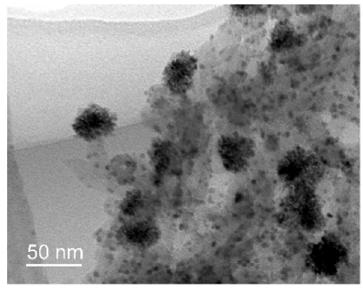
Figure 5. TEM image of Ru/CNT (carbon nanotube) nanocomposites.